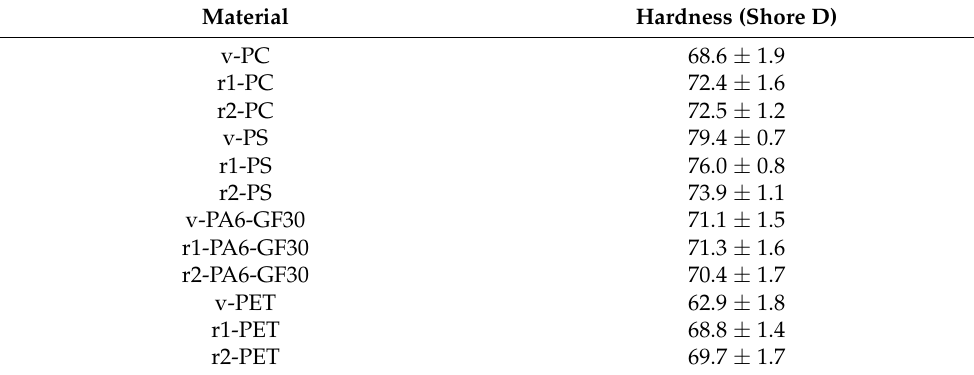
Table 4. Shore D hardness results of virgin and recycled materials were tested according to the guidelines in ISO 868:2003